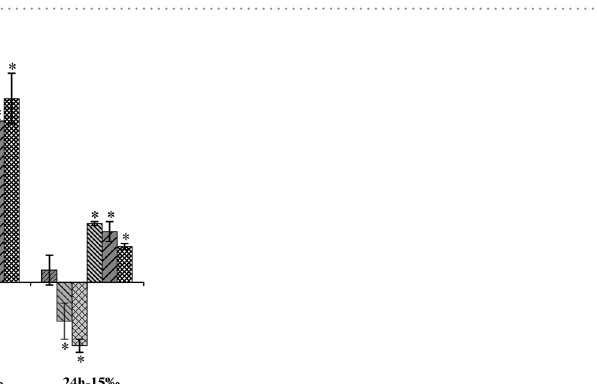
Figure 2. Relative mRNA expression of CgCSAD1 in different families of juvenile oyster under low osmotic stress. Elongation factor 1 α (EF) gene expression was used as internal control. The samples acclimated in 30‰ for 8 hours and 24 hours are the reference samples, respectively. The y-axis represent the fold changes between the expressions of treated samples and reference samples. Vertical bars represent the mean ± SD (N = 6). * Indicated the significant different (fold change > 2, p < 0.05), CSAD: Cysteine sulfinate decarboxylase.